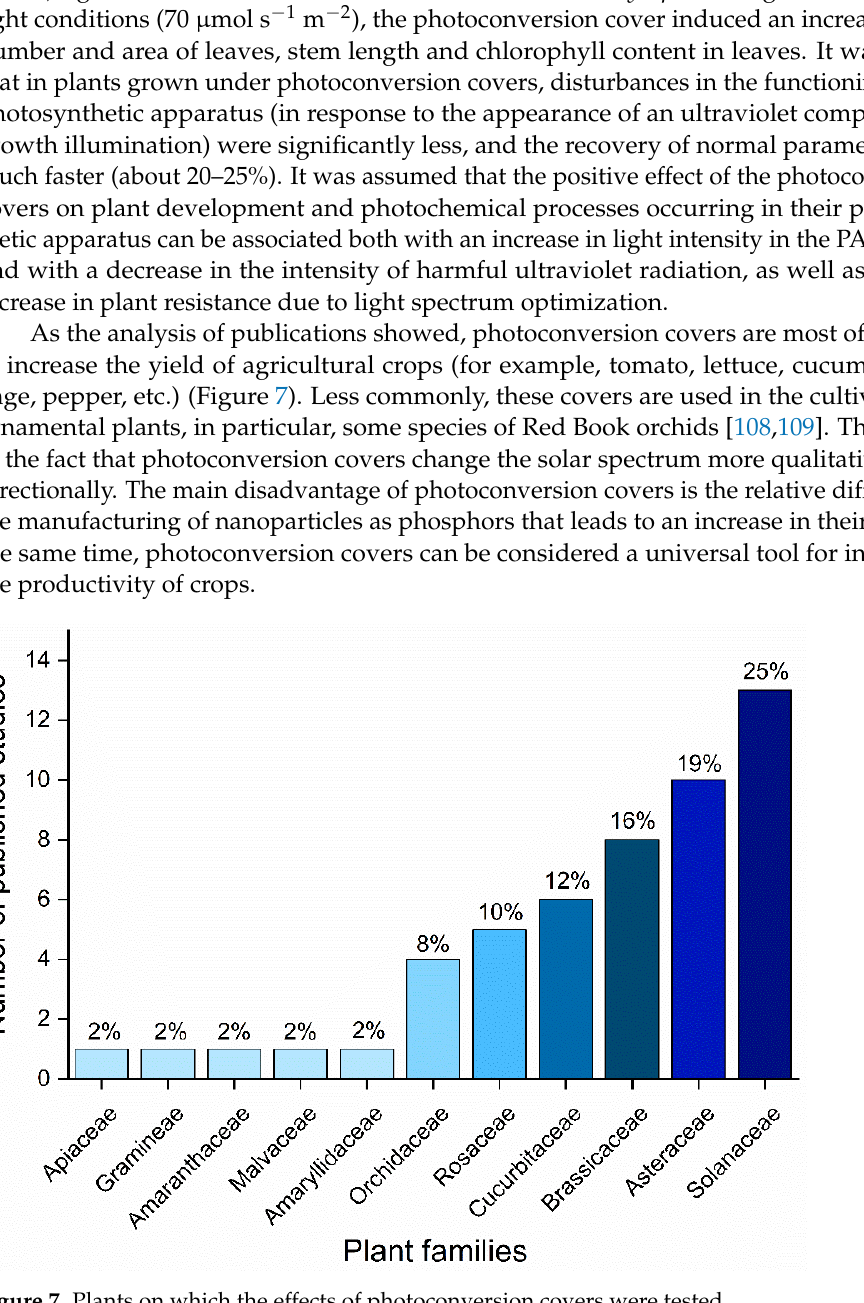
Figure 7. Plants on which the effects of photoconversion covers were tested.